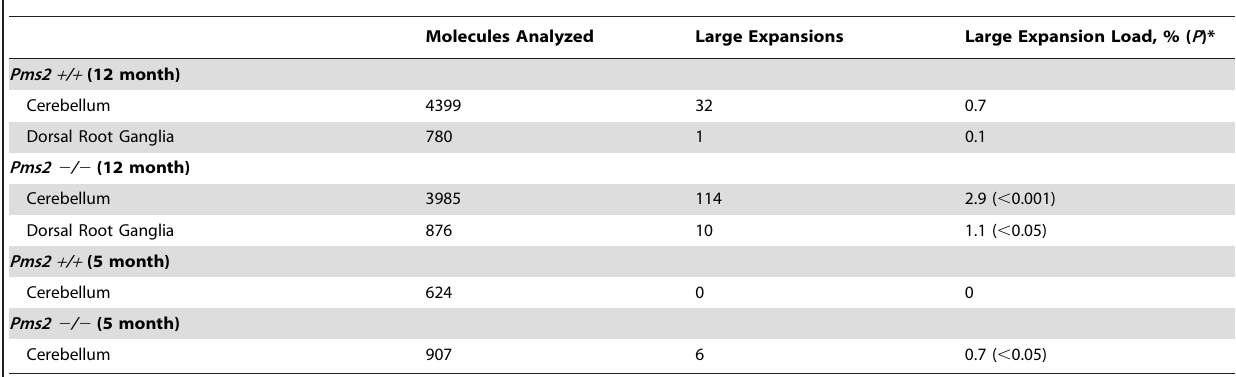
Table 3. Effect of Pms2 on large expansions in cerebellum and